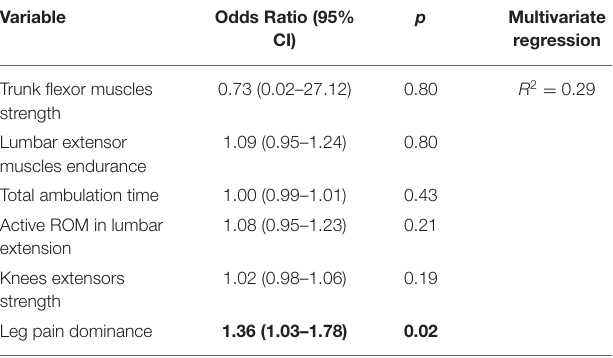
TABLE 1 | Participants’ baseline characteristics.